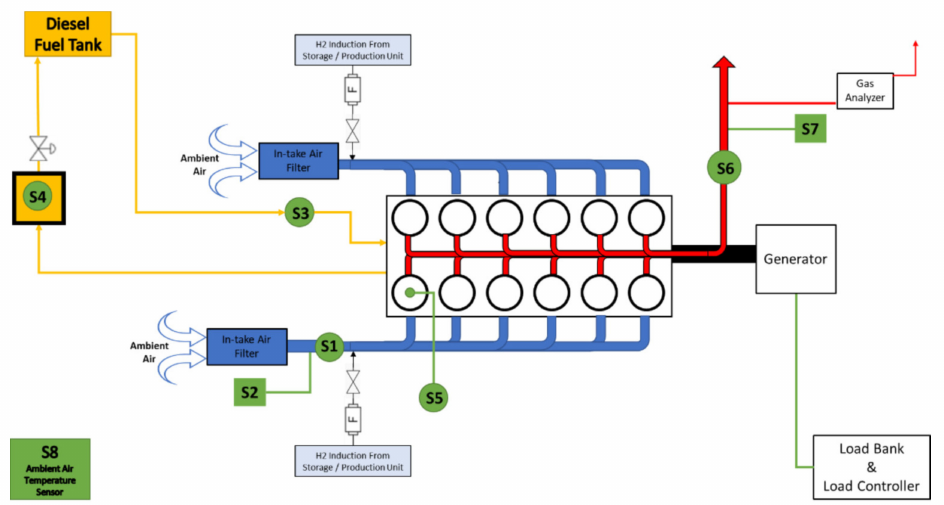
Figure 1. Experimental apparatus of the modified CI diesel engine arrangement and measurement instruments, for monitoring the engine’s performance with and without H 2